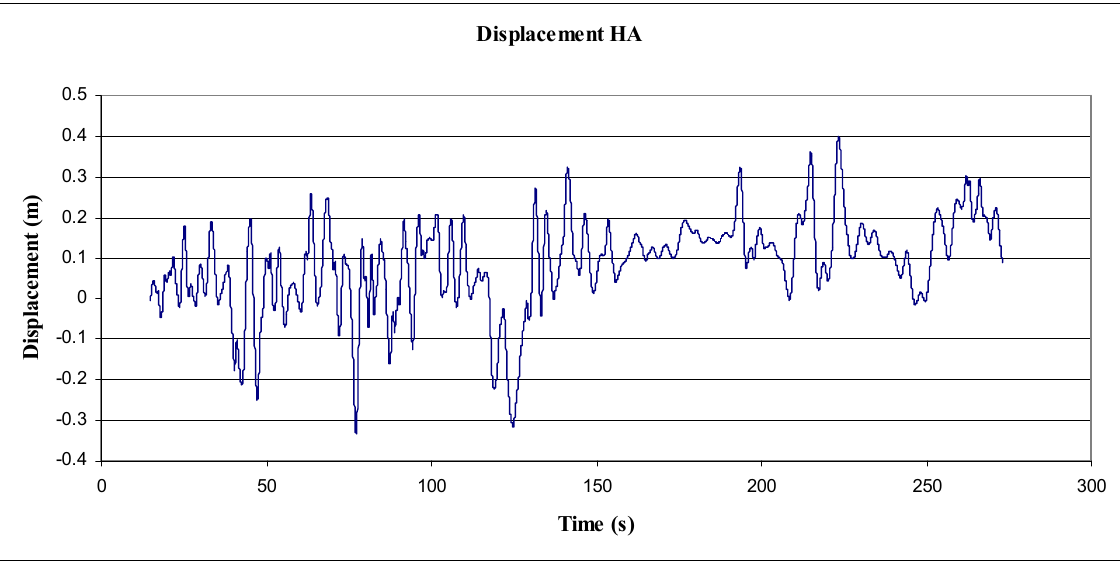
Figure 16. Derived displacement in horizontal axis, HA.